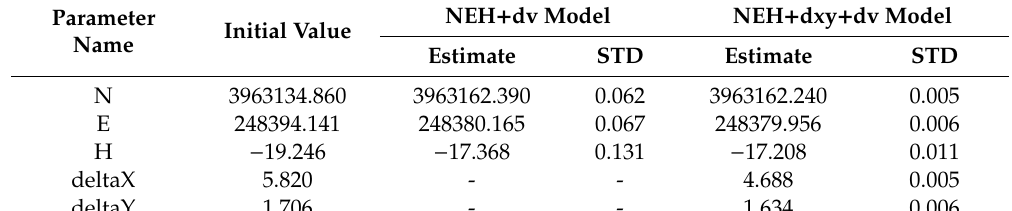
Table 4. Results of Two Estimation Models (Unit: m).